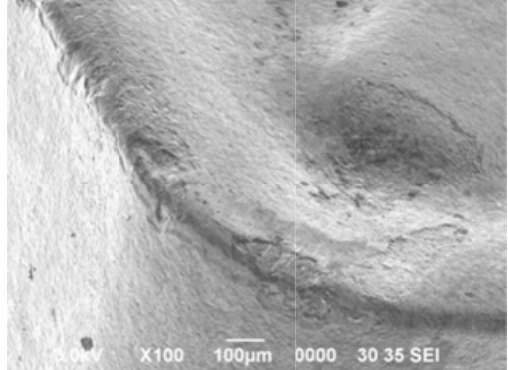
Figure 10. Crater wear at V c D 50 m = min, f D 0:08 mm = rev, and d D 0:4 mm.